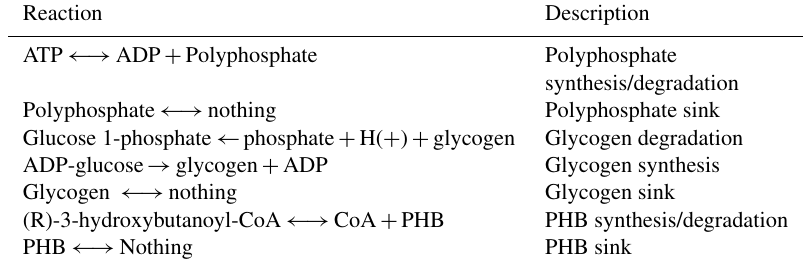
Table 1. Comparison of curation and automated annotation. Major manually curated pathways Predicted in Predicted in All amino acid biosynthetic pathways X X Ammonium assimilation X X Bifidobacterium shunt X X Heterolactic acid fermentation Homolactic acid fermentation X X Mixed acid fermentation Nucleoside triphosphate biosynthetic pathways X X Photosynthetic light reactions X Calvin cycle X X Nitrate assimilation X Nitrogen fixation Glycogen biosynthesis X Glycolysis Hydrogen production Pentose phosphate cycle Sulfur and sulfate reduction Tricarboxylic acid (TCA) cycle Peptidoglycan biosynthesis Cyanophycin synthesis Polyphosphate synthesis X Table 2. Modeled biopolymer reactions.